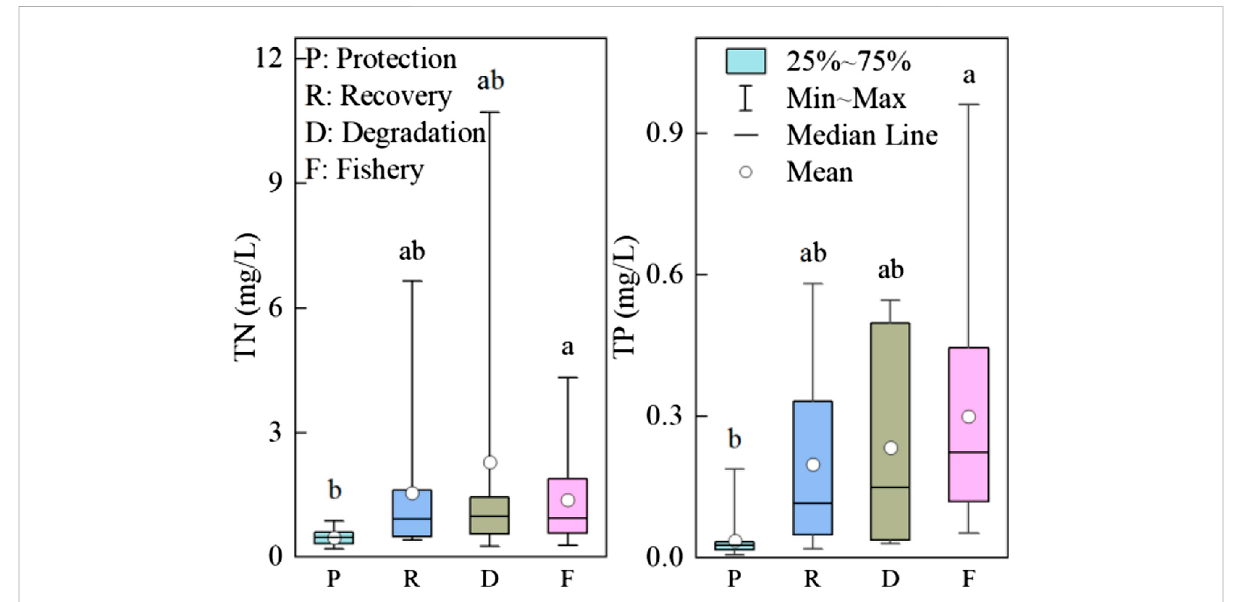
FIGURE 6 N and P concentrations in small water bodies under different management